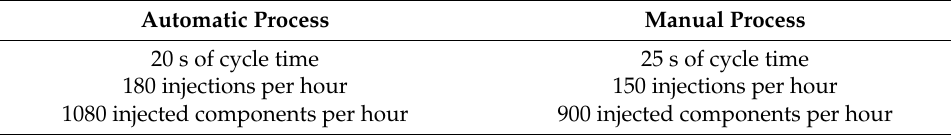
Table 2. Automatic process vs. manual